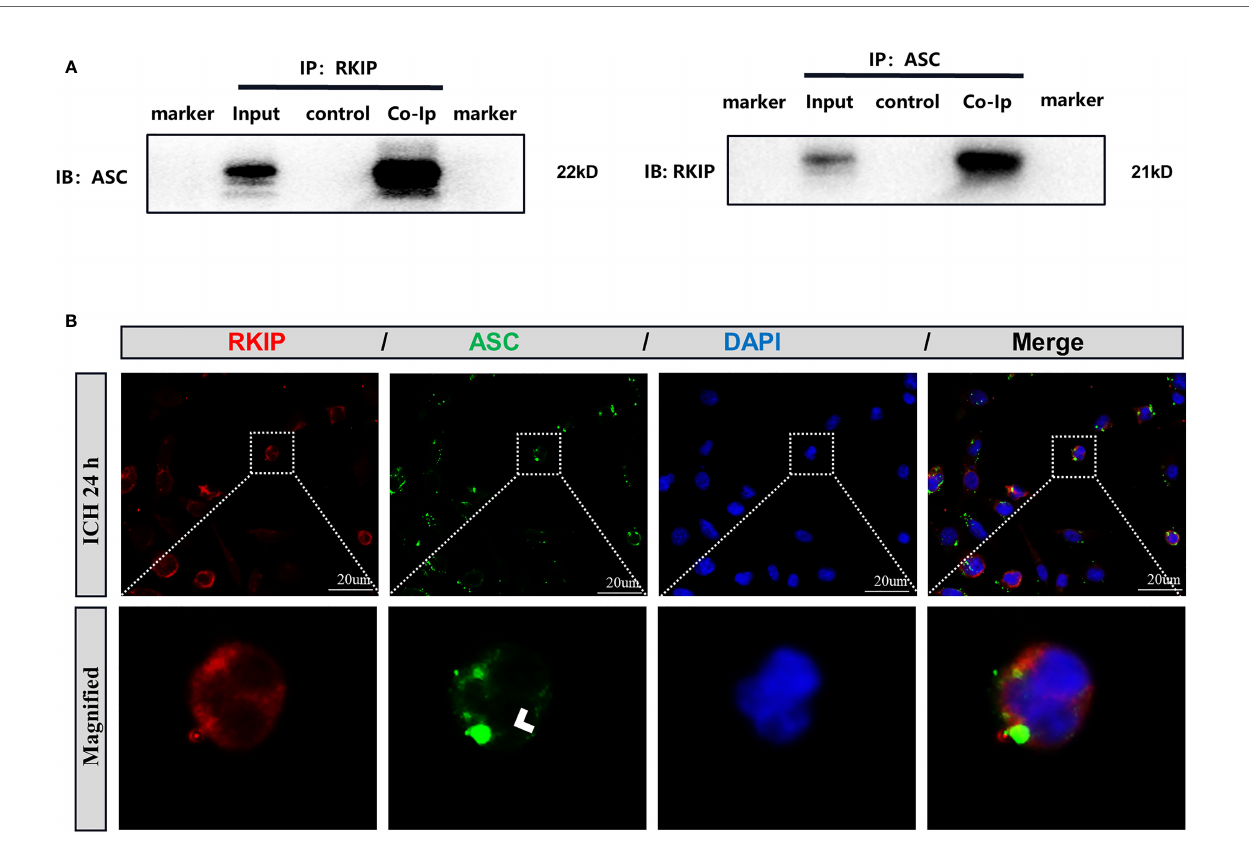
FIGURE 8 | Rkip directly interacts with Asc. (A) Co-immunoprecipitation of Rkip and Asc n = 6 for each group. (B) Rkip/Asc double immuno fl uorescence staining showed that Rkip combined with Asc co-expressed after LPS stimulation in the BV-2 cells. Scale bar = 20 m m. n = 3 for each